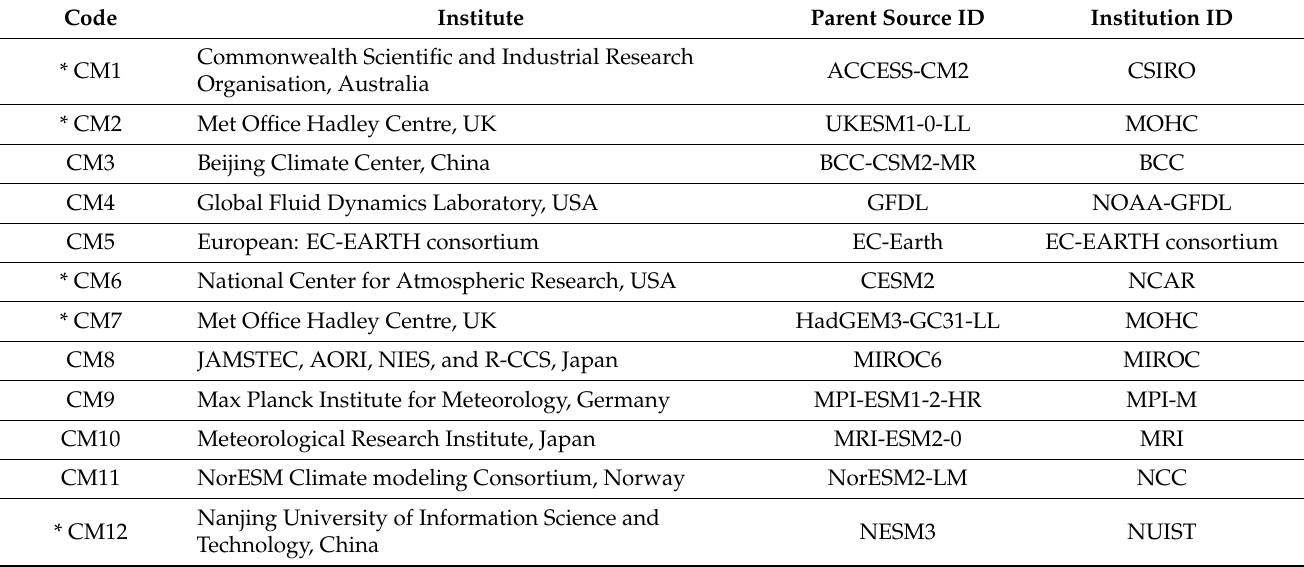
Table 1. Details of the 12 CMIP6 Earth System Models (ESMs) included in the analysis. ESMs marked with an asterix indicate those showing high climate